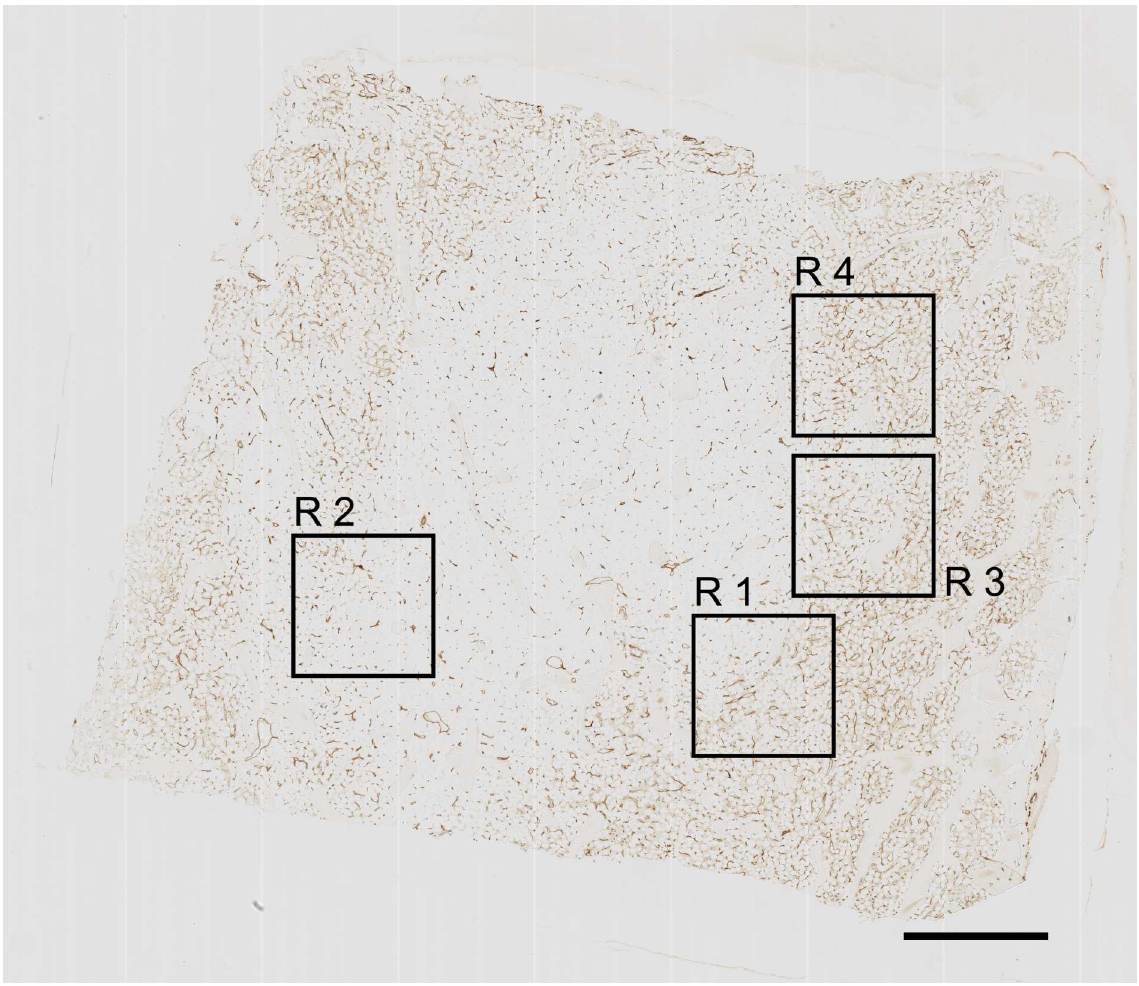
Fig 3. The first of 21 serial sections immunostained for CD34 plus CD141with regions of interest R1 to R4. Scale bar = 1